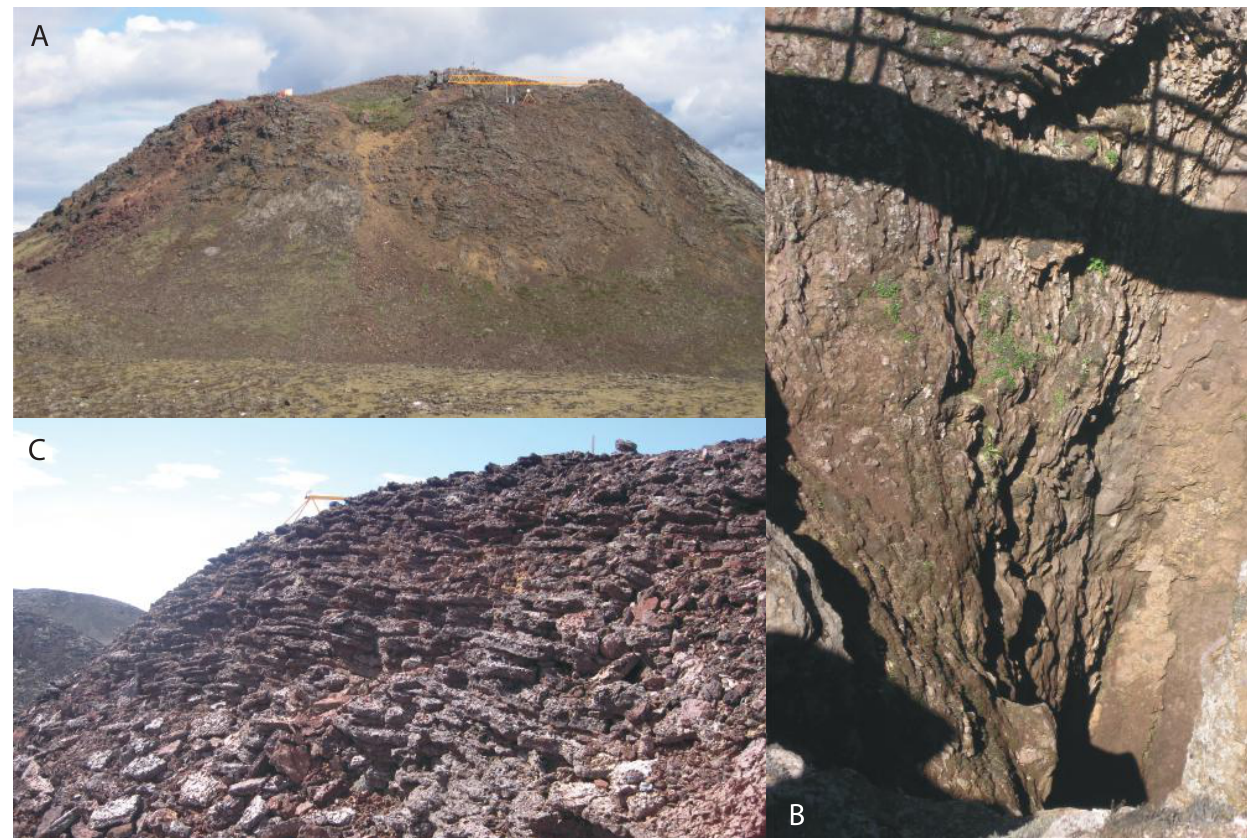
Figure 2: The main edifice of Thríhnúkagígur is composed of two vents [A] and its southern vent remains evacuated and open, which is exploited to lower tourists into the conduit and cave system by a cable lift seen in yellow. Lava drainback textures are visible descending into the vent at the surface [B], which was a repeated and episodic process as is evident from the layers of thin clastogenic flows around the summit of the cone